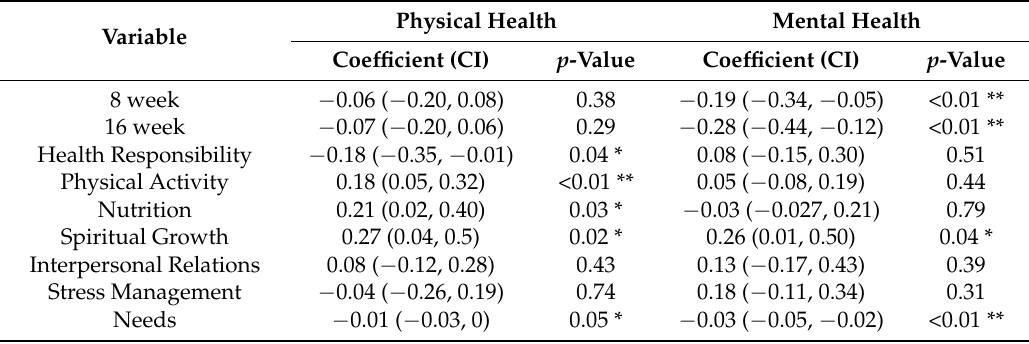
Table 4. Predictors associated with PH and MH in longitudinal analysis; generalized estimating equations (GEEs).